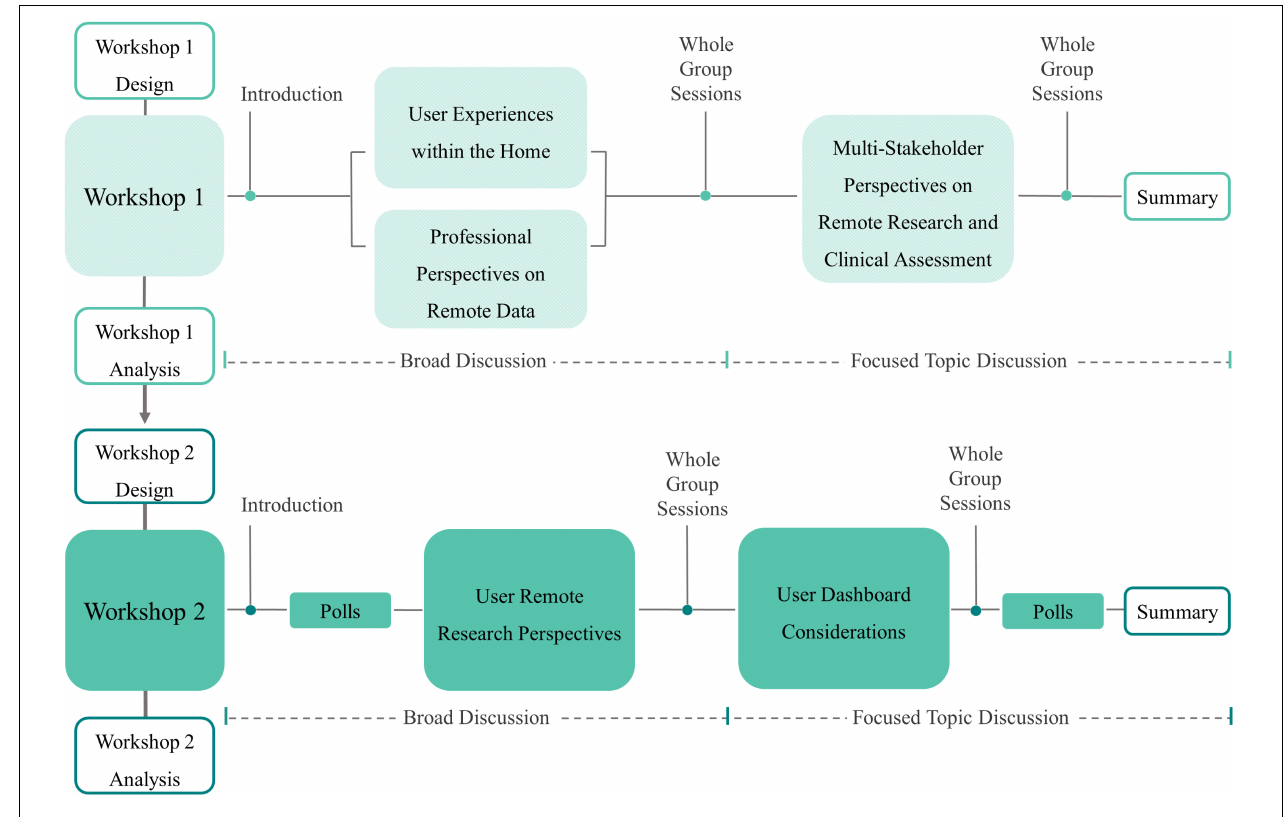
FIGURE 1 | Overview of the structure of Workshops 1 and 2.